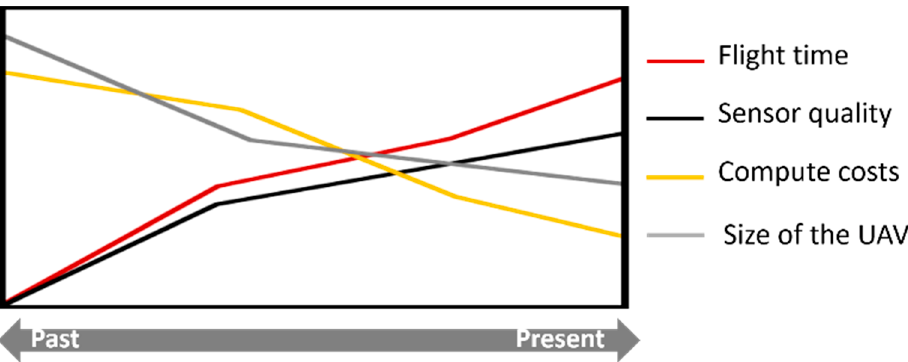
Figure 1. The evolution of UAV-based remote sensing in terms of associated costs, sensors’ quality and UAVs’ autonomy (adapted from PrecisionHawk [17]).